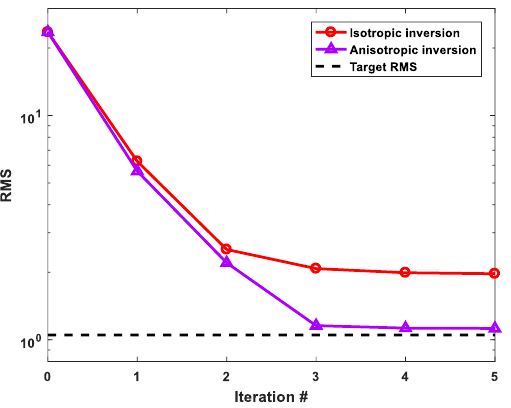
Figure 13. Convergence plot for the isotropic and anisotropic inversion. The black dashed line indicates the threshold RMS.